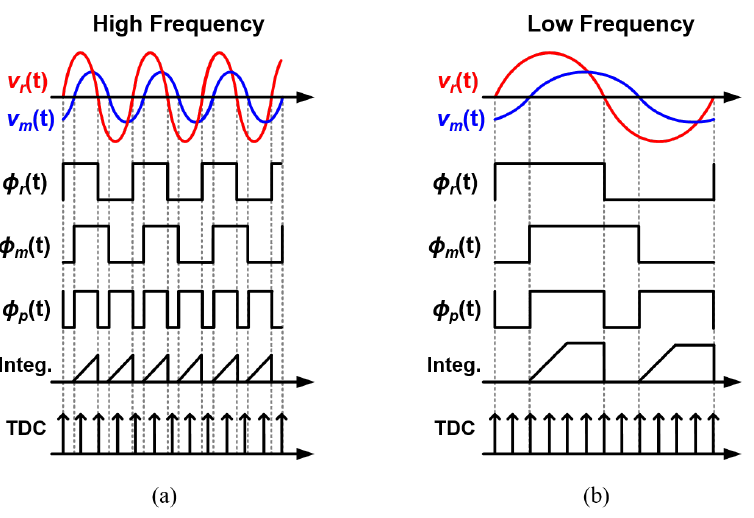
Figure 4. Conceptual representation of the phase-detection process ( a ) at high frequency and ( b ) low